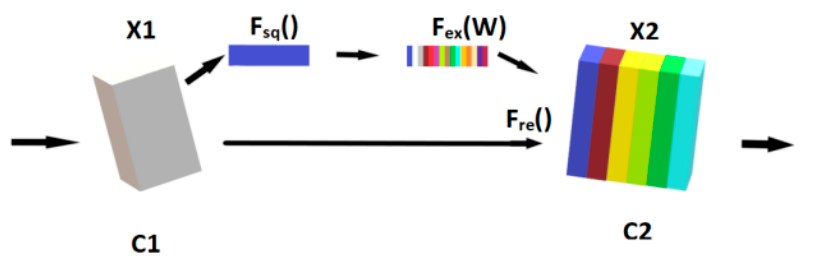
Figure 2. The channel attention module.